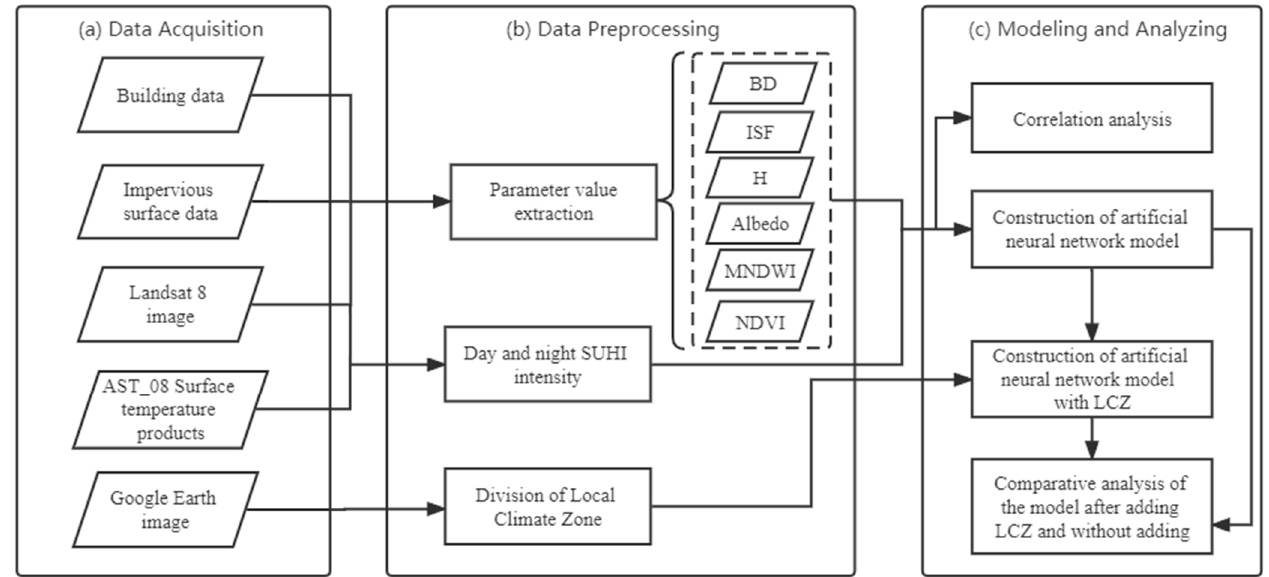
Figure 3. Research Figure 3. Research methods.